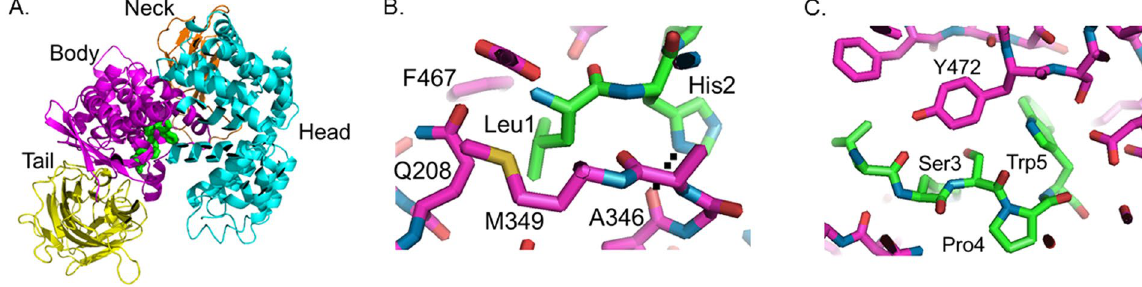
Figure 4. Molecular modeling of the peptide LHSPW in the active site of pAPN. ( A ) Structure of pAPN complexed with the modeled LHSPW peptide (green) depicting the pAPN ectodomain and its four components: head (cyan), neck (brown), body (in magenta), and tail (in yellow). For the modeling of peptide LHSPW in the active site of APN, two crystal structures were used: ( B ) the first three residues (Leu1-His2- Ser3) were modeled from the structure of pAPN complexed with polyalanines (PDB ID: 4NAQ), and ( C ) last two residues (Pro4-Trp5) were from the structure of pAPN complexed with substance P, which also contains a proline at the 4th position (PDB ID: 4HOM).